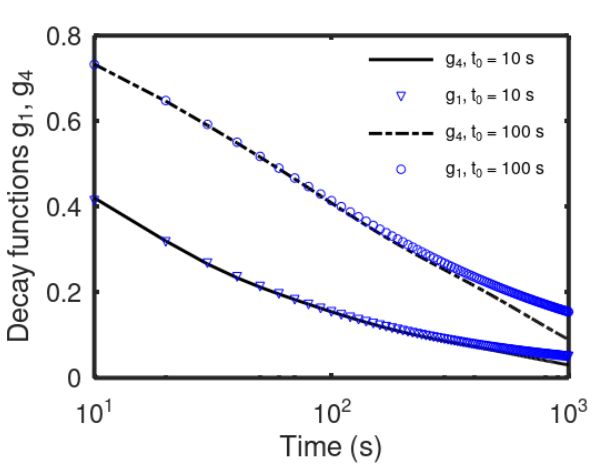
Figure 5. Absolute values of the real part (resistance) and imaginary part (reactance) of a CPE with α = 0.5 of an approximation with a five-element RC network.